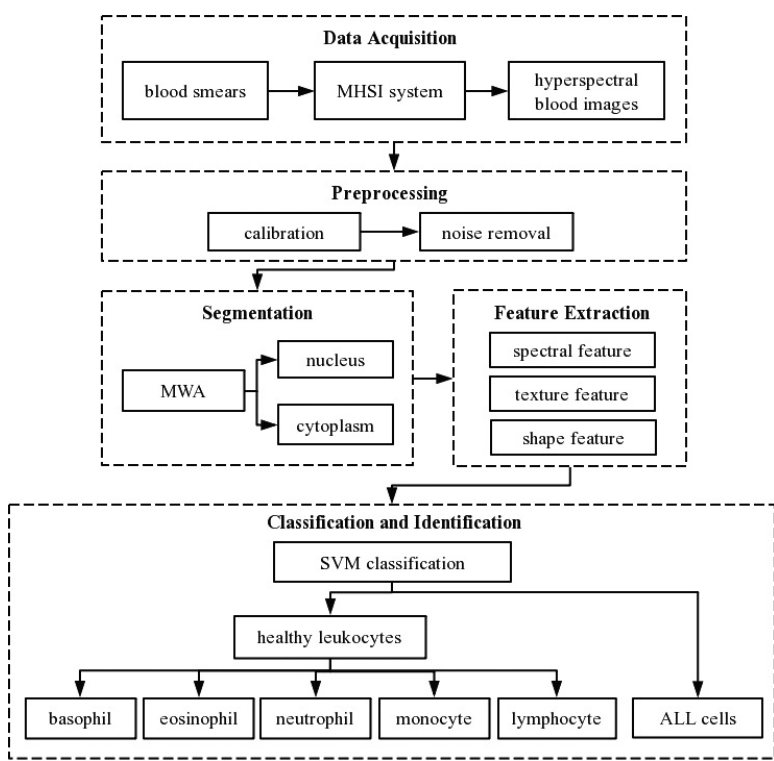
Fig. 2. Flowchart of the proposed